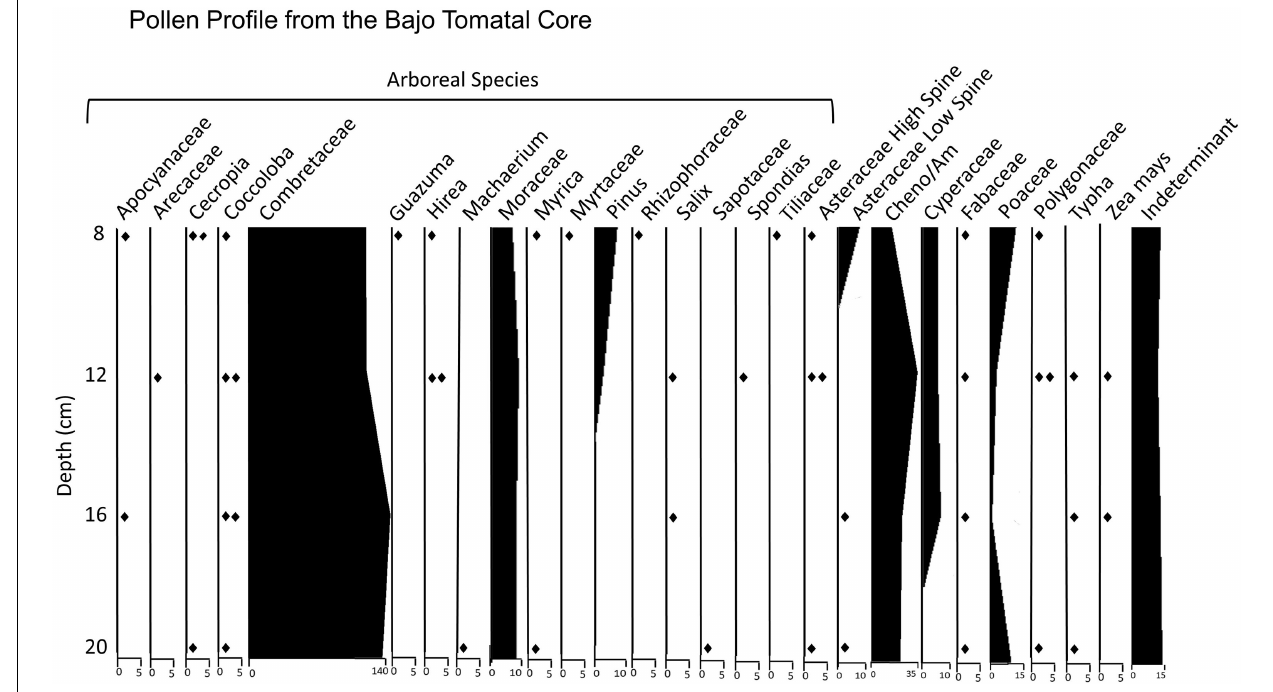
FIGURE 7 | Pollen profile from Operation 19V, the South Tom Reservoir core. Sediment from 25 cm BS yielded a Late/Terminal Preclassic calibrated date of 80–250 CE. Organic matter from 15 cm produced an AMS date of 660–960 CE.